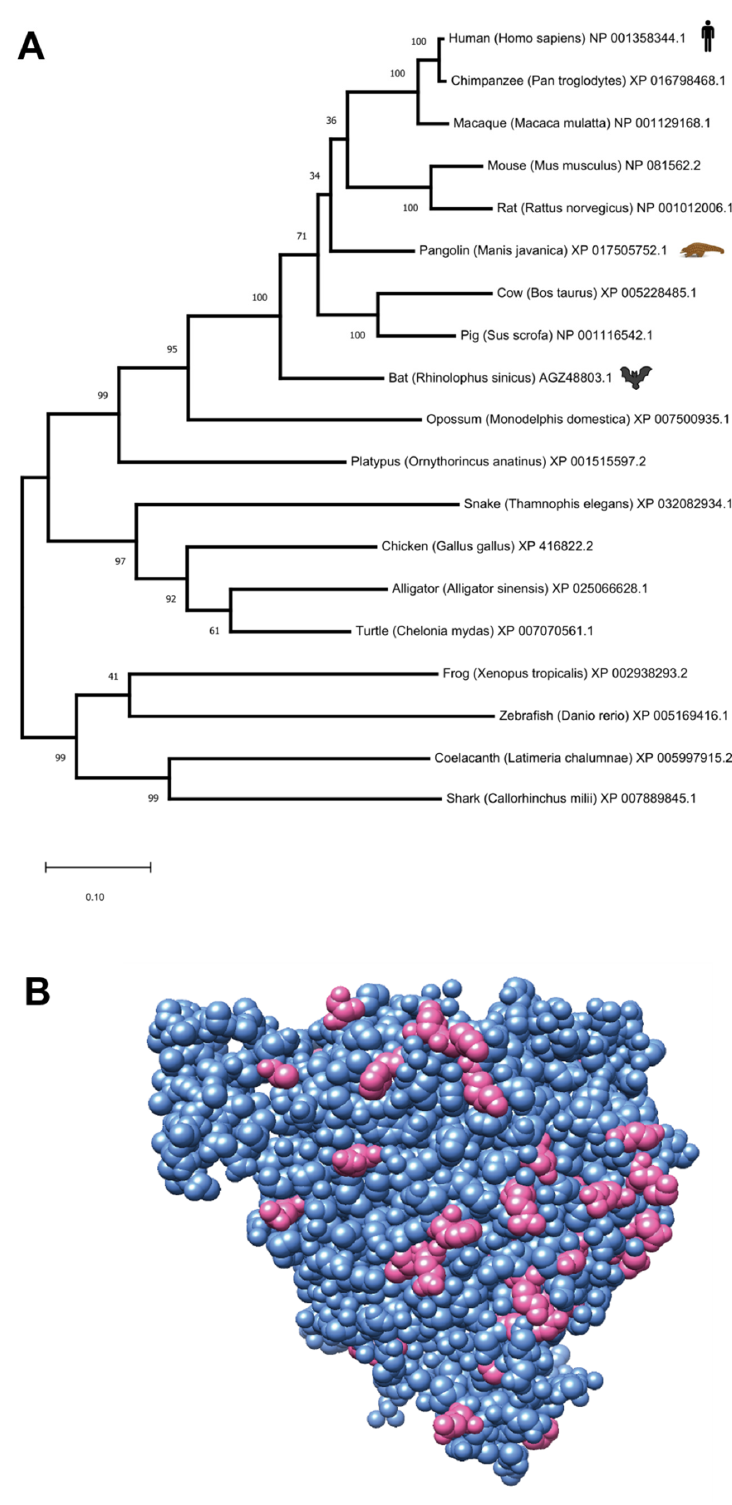
Figure 4. Cross-species analysis of the Angiotensin-converting enzyme 2 (ACE2) protein. ( A ) Maximum -likelihood evolutionary tree of ACE2 orthologs in selected vertebrates (numbers in the branch points indicate the % bootstrap supporting the branch structure). The tree is drawn to scale, with branch lengths measured in the number of substitutions per site. ( B ) A visualization of a human ACE2 crystal structure (resolution: 2.2 Å, PDB:1R42). The residues that are conserved across human, pangolin and bat are depicted in cornflower blue, and the residues that are conserved in human and pangolin but differ in bat (Supplementary Table S3) are depicted in opaque